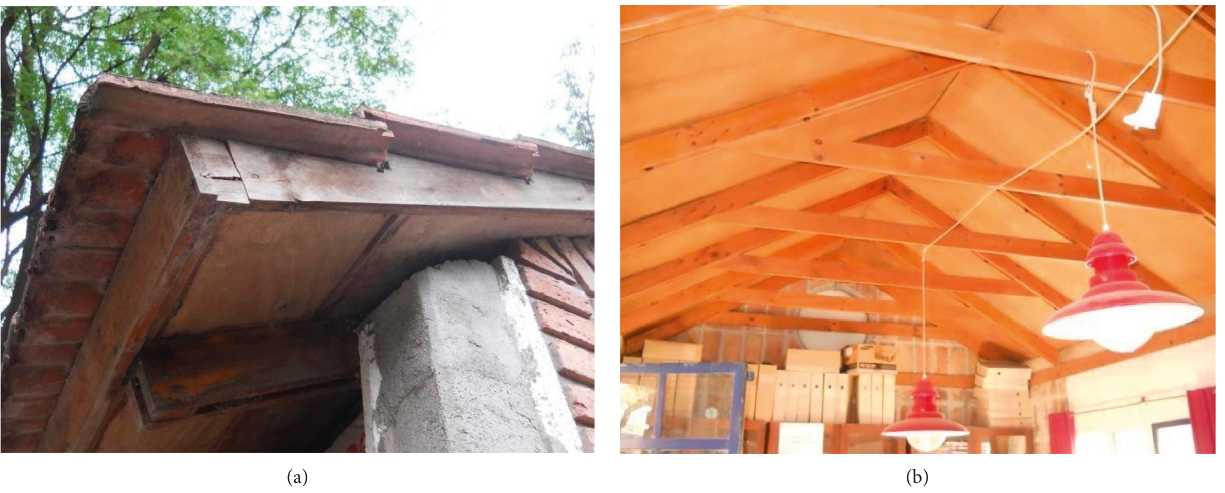
Figure 5: Picture with a detail of the cover (a) and picture with the interior of the house